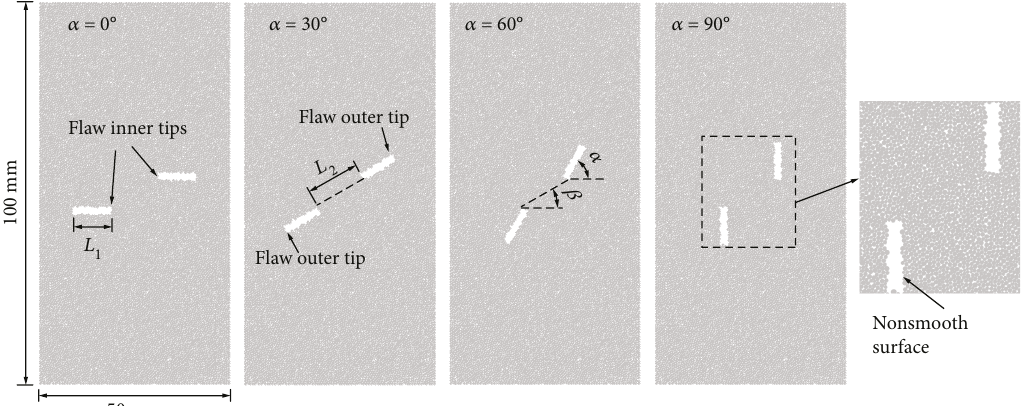
Figure 7: Numerical marble specimens containing two pre fl